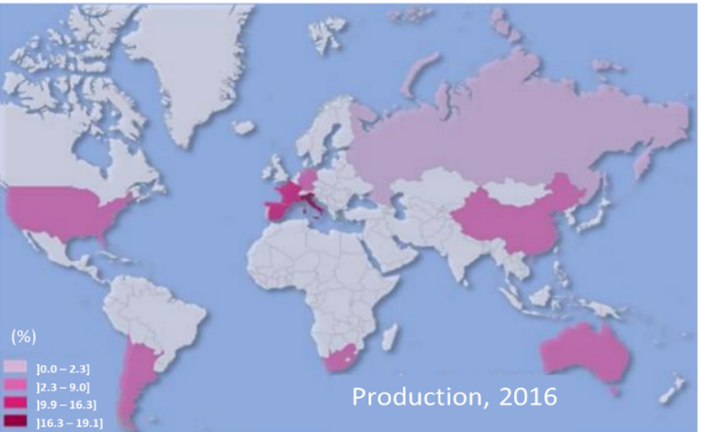
Figure 4. World geography of wine and grape production in 2016. Adapted from Hogg and Rebelo [30] .